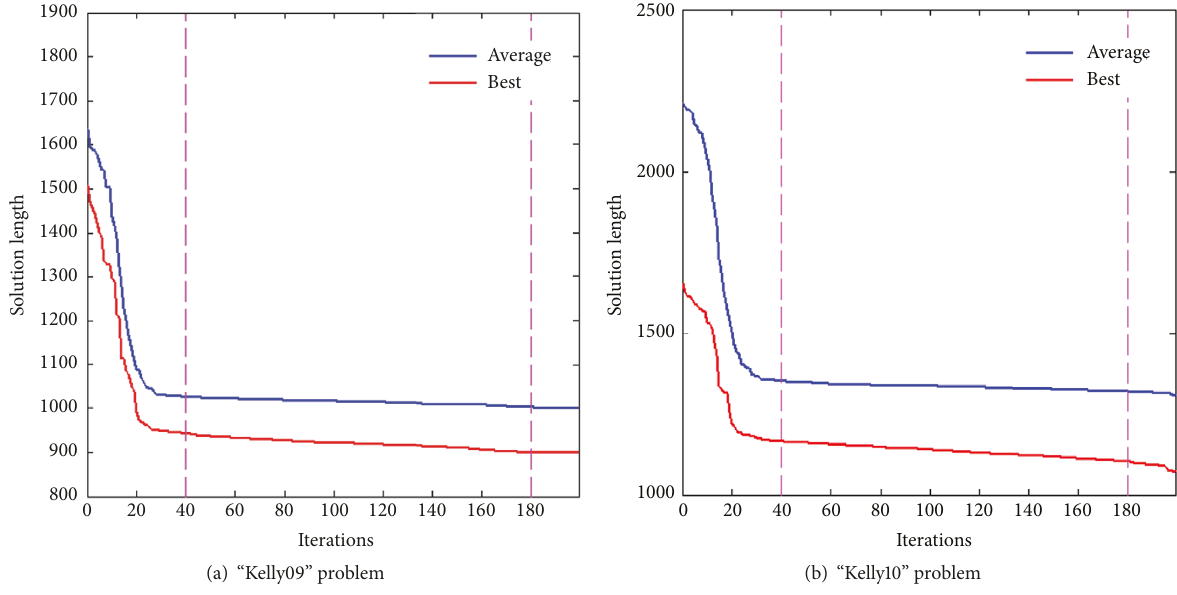
Figure 8: Examples of convergence characteristics.